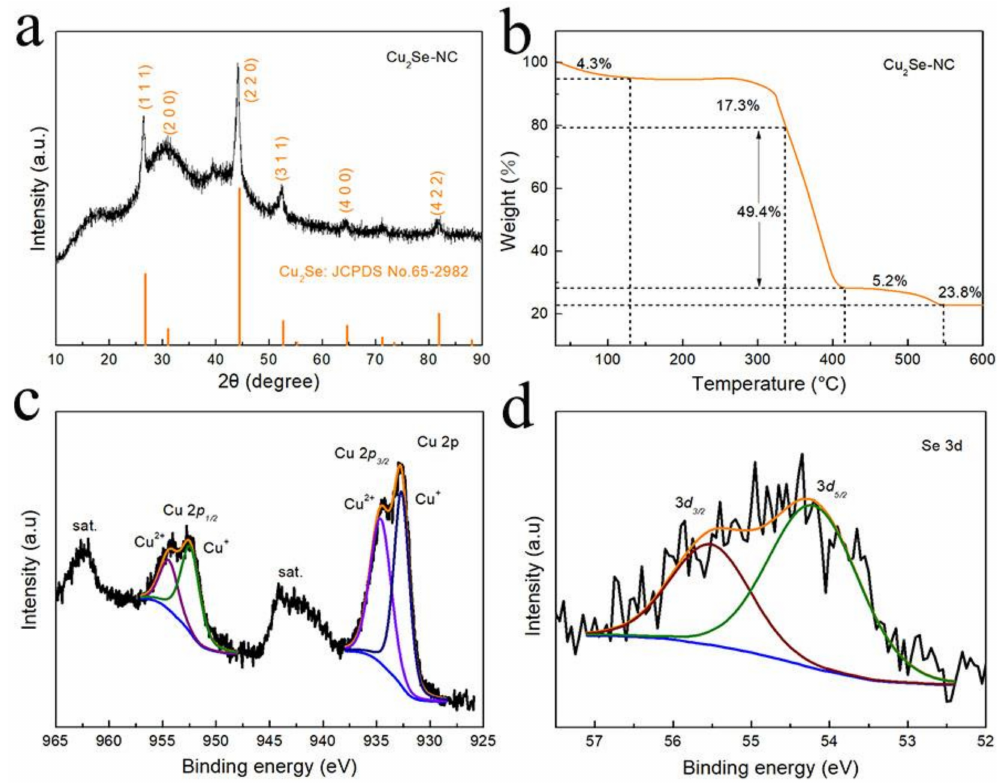
Figure 2. ( a ) XRD pattern of Cu 2 Se-NC; ( b ) TGA spectra of Cu 2 Se-NC; XPS spectra of ( c ) Cu 2p; ( d ) Se 3d of the Cu 2 Se-NC,